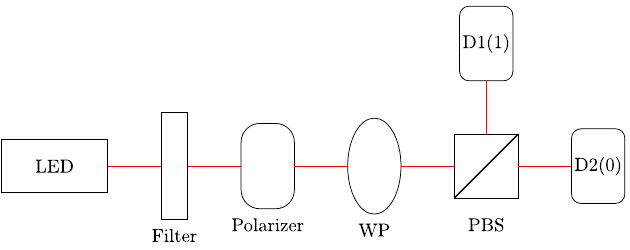
Fig. 1. Schematic diagram of the experimental